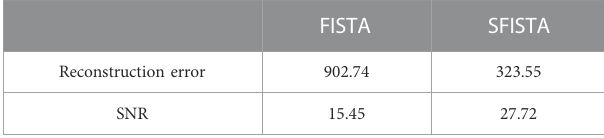
TABLE 4 Reconstruction error and SNR of different